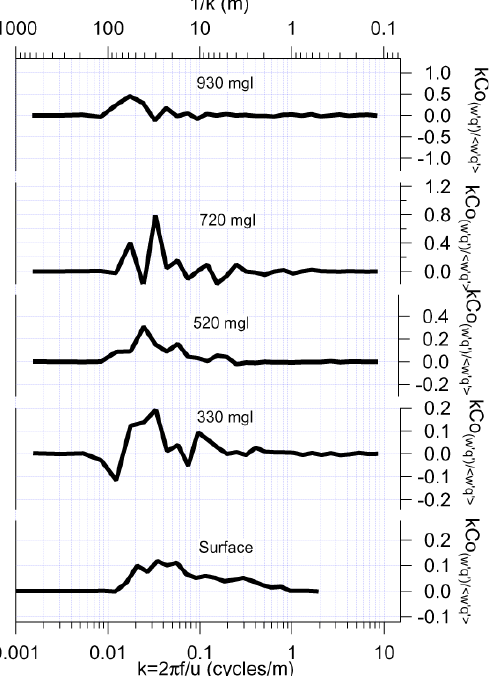
Fig. 13. Averaged Cospectral plots of < w 0 q 0 > normalized to the total variance from UAV FT A and surface data. Tower data are for a 30-min period from 11:17.